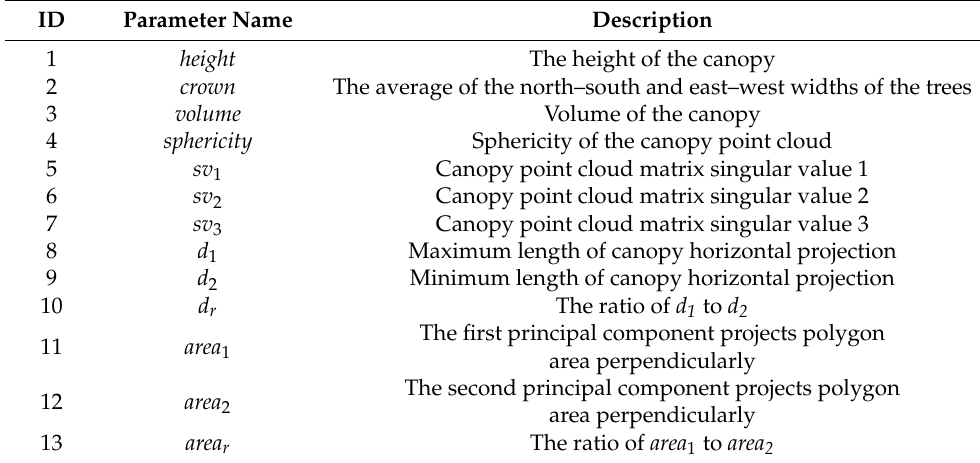
Table 2. Individual tree feature parameters.